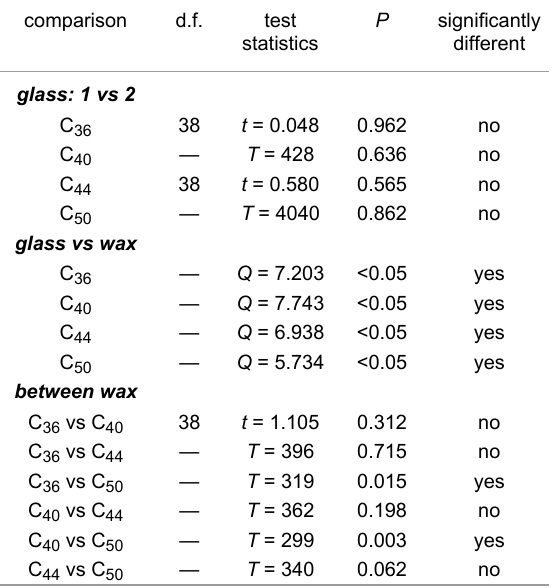
Table 2: Results of statistical analyses (Tukey test performed after Kruskal–Wallis one way ANOVA on ranks and one way ANOVA) of morphometrical variables of wax crystals between different wax samples. a comparison q P significantly